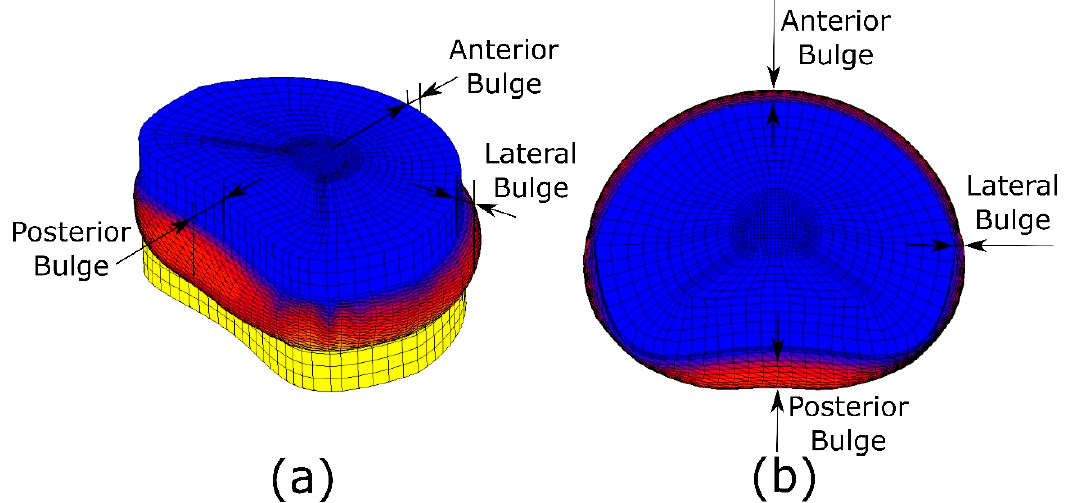
Figure 3. ( a ) Three-dimensional view of bulges and ( b ) actual dimension of the anterior, posterior, and lateral bulges.